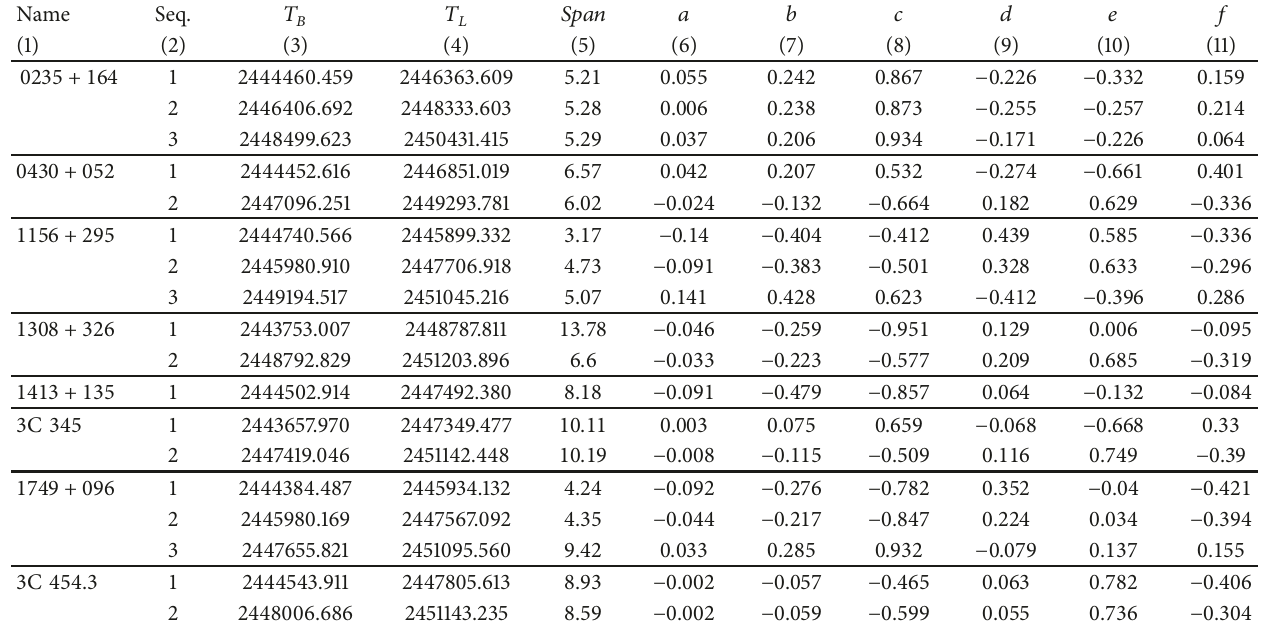
Table 3: The elliptic fitting of 8